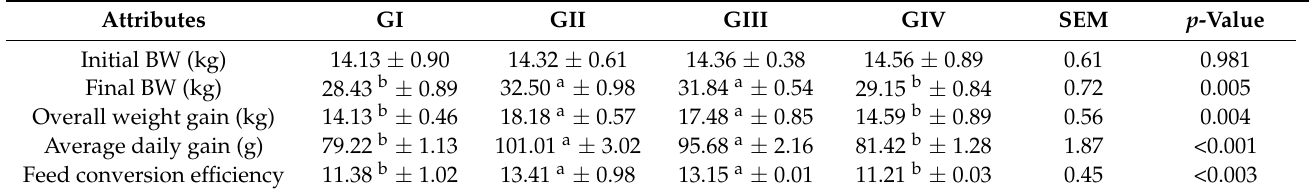
Table 4. Growth performance of goats during the feed trial: GI (control), GII (60R:40C with 10% of concentrate replaced with ML), GIII (70R:30C and 20% replacement of concentrate with ML), and GIV (80R:20C and 20% replacement of concentrate with